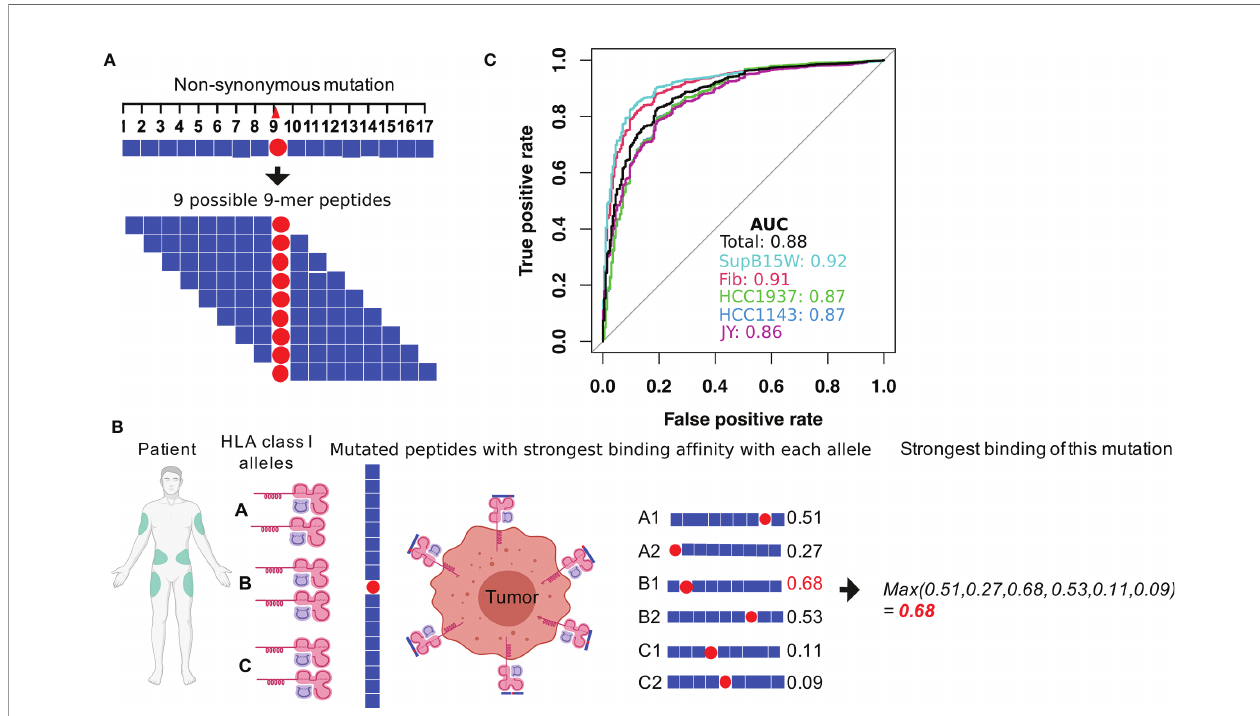
FIGURE 1 | Calculation of the MHC-I binding af fi nity of the neoantigen derived from a non-synonymous mutation. (A) For each mutation, a total of 17 amino acids centering at the mutated site were considered. The binding af fi nities with MHC-I complex of the nine possible 9-mer peptides were calculated by using NetMHCPan4.0 (25). (B) During the MHC-I binding af fi nity calculation, patient-speci fi c HLA genotypes were used. Each patient has two alleles for HLA-A, B, and C gene, resulting in six total alleles. For each allele, MHC-I binding af fi nities to the nine 9-mers were calculated. The fi nal MHC-I binding af fi nity of the somatic mutation was calculated as the maximum value of the 9 (peptides) × 6 (alleles) binding scores. Figure created using BioRender (https://biorender.com/). (C) The performance of our MHC-I binding af fi nity pipeline was evaluated by classifying MHC binding and non-MHC binding epitopes in experimental data from previous studies (26, 27). The data provided peptide sequences for a collection of MHC binding and non-MHC binding epitopes in 5 different human cell lines (Fibroblast, SupB15W, JY, HCC1937, and